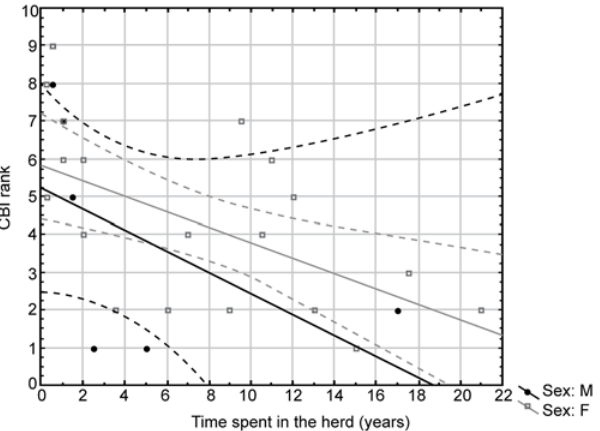
doi:10.1371/journal.pone.0124570.g001